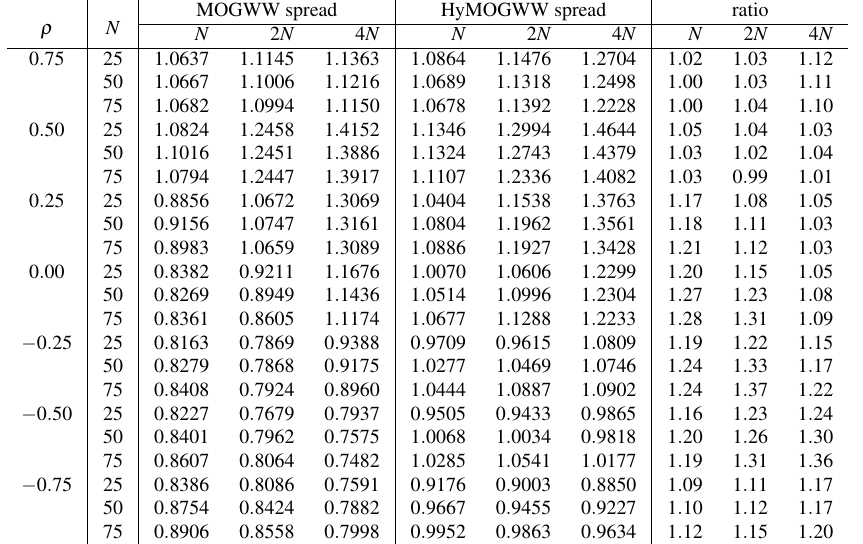
Table 2: Spread diversity measure for MOGWW and HyMOGWW (using W-RoTs as reference front). MOGWW spread HyMOGWW spread ratio ρ N